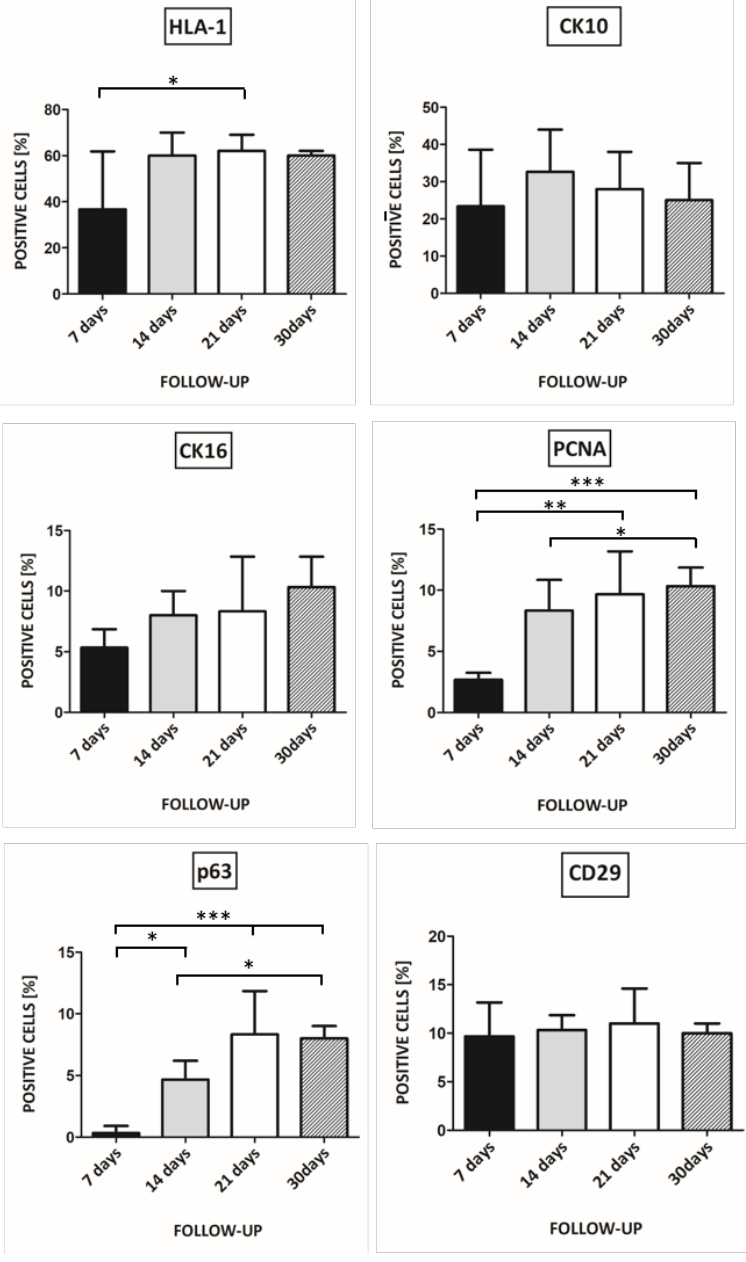
Figure 4. The percentage of keratinocytes in newly formed epidermis positive for HLA-1, CK10, CK16, PCNA, p63, and CD29 depending on follow-up time. Statistically significant results are shown at the bar graph (* p < 0.05, ** p < 0.01, *** p < 0.001). After 21 days of follow-up, complete wound healing was observed, and a full blood supply to the graft bed was visible. In the histology, no differences in healing were observed between control (fresh KCs) and experimental (preserved KCs) groups (Figure